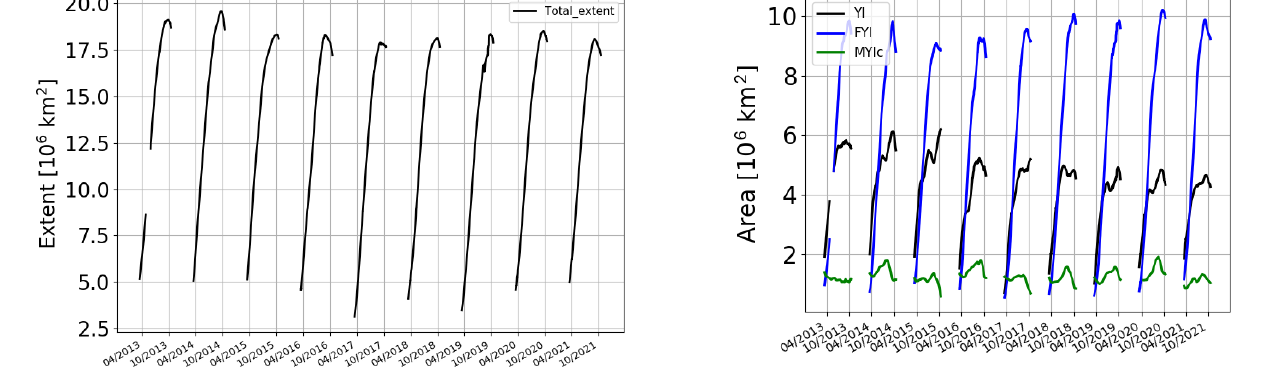
Figure 14. Areas of the three sea ice types YI (black), FYI (blue), and corrected MYI (green) for the years 2013–2021, March to Oc- tober, smoothed with a 31d moving average.